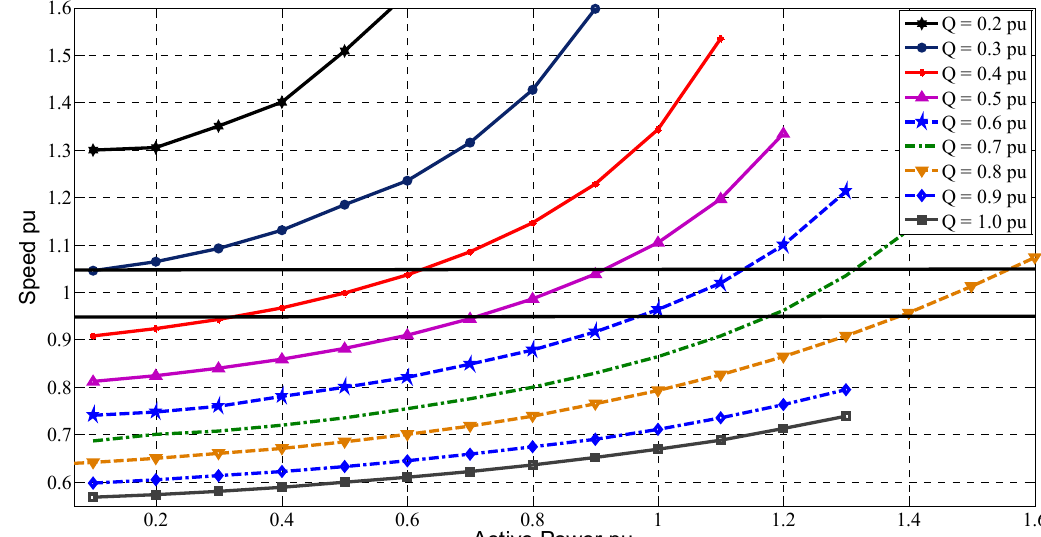
Figure 7. Variation of speed with active and reactive